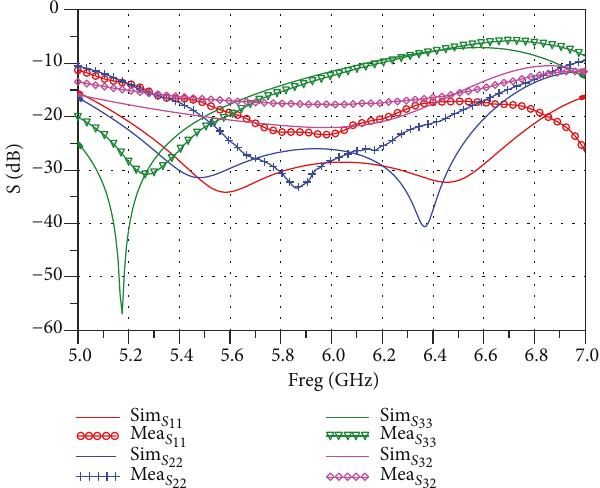
Figure 10: Comparisons of S electromagnetic simulation in ADS and measurement.